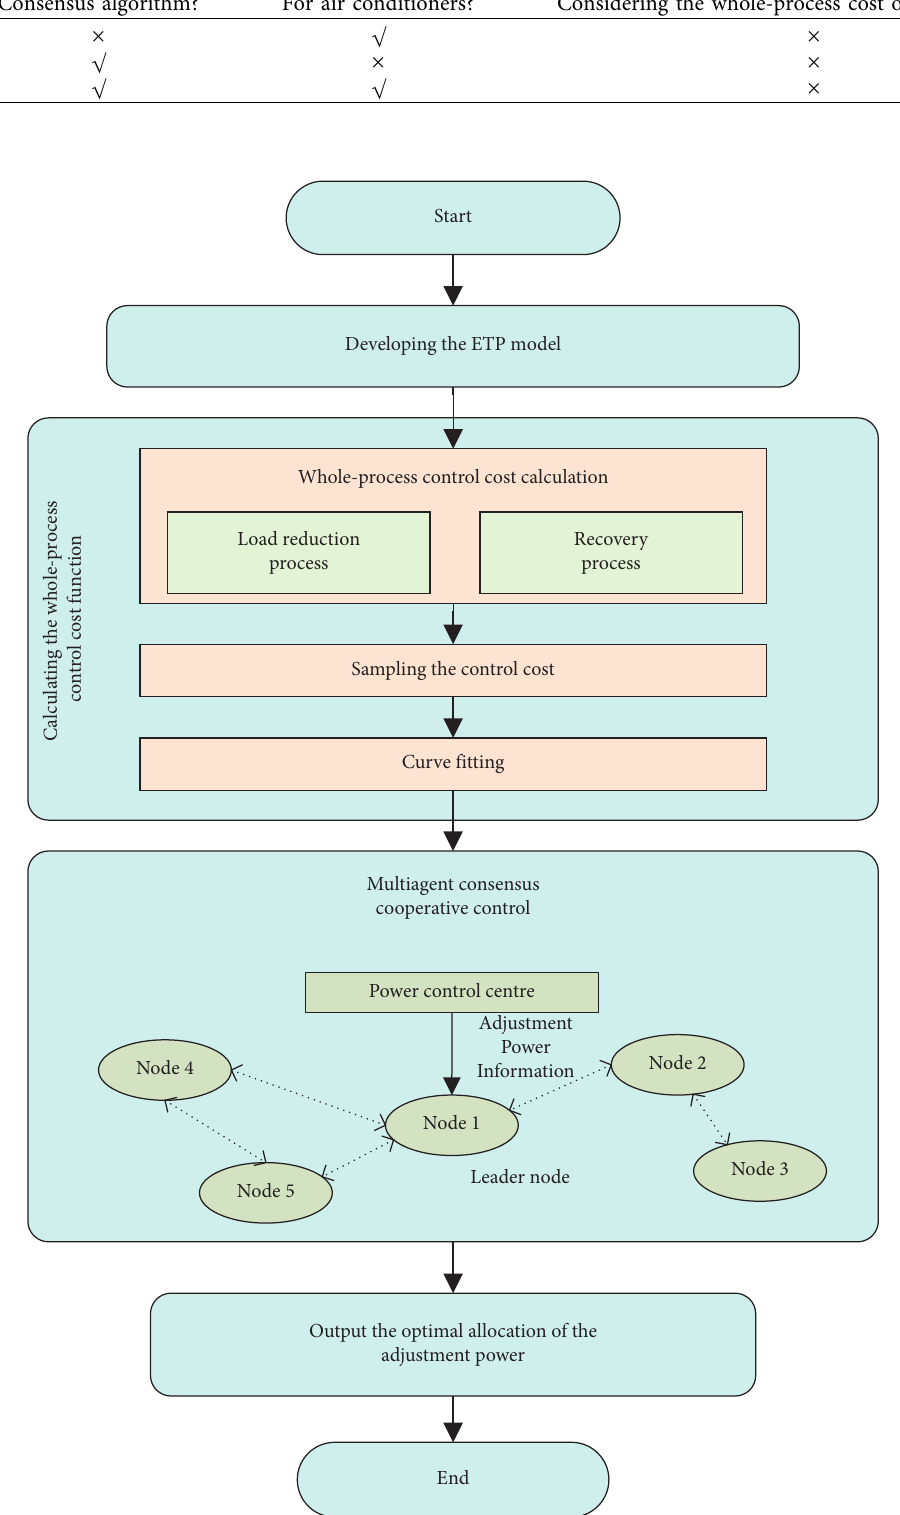
Figure 1: The overall flowchart of the proposed